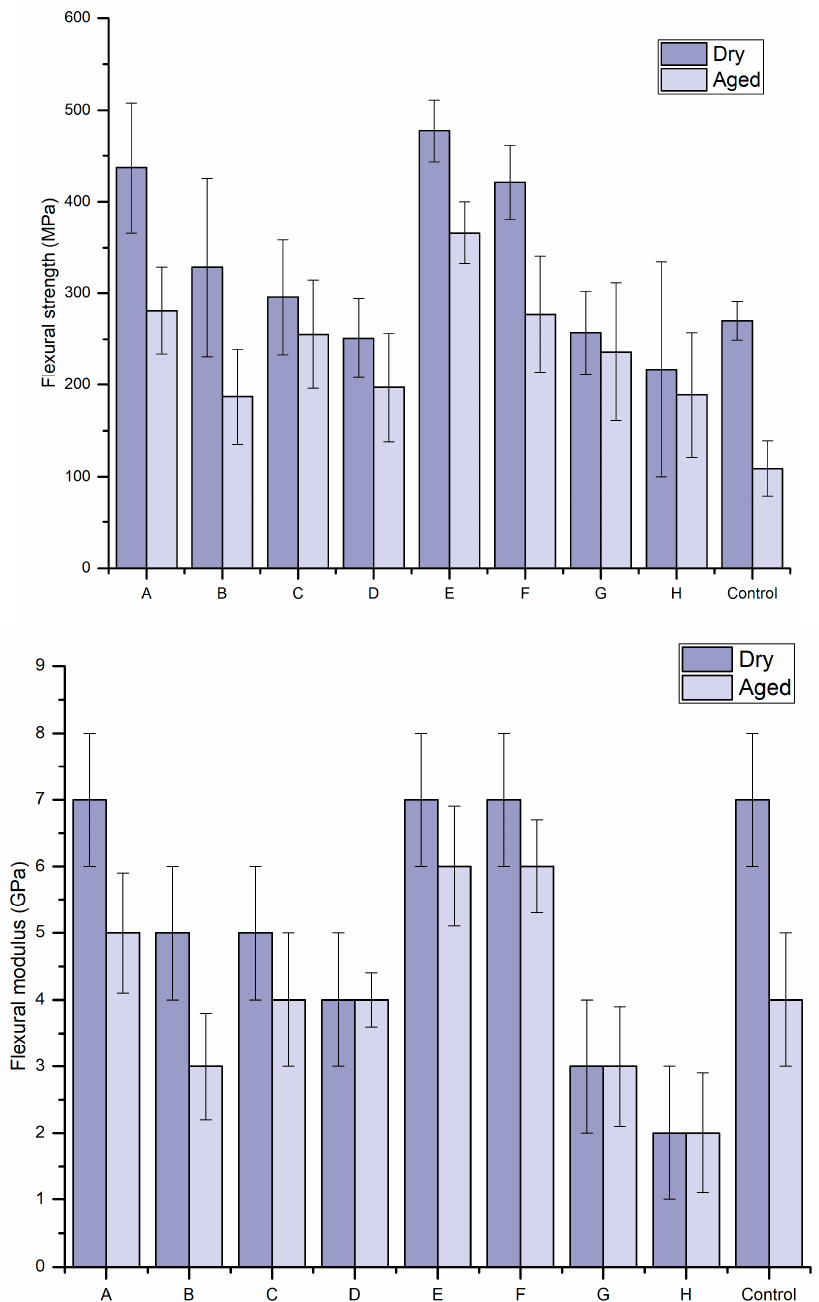
Figure 2. Bar graph showing mean flexural strength (MPa) and flexural modulus (GPa) with the standard deviations (SD) of the tested groups.